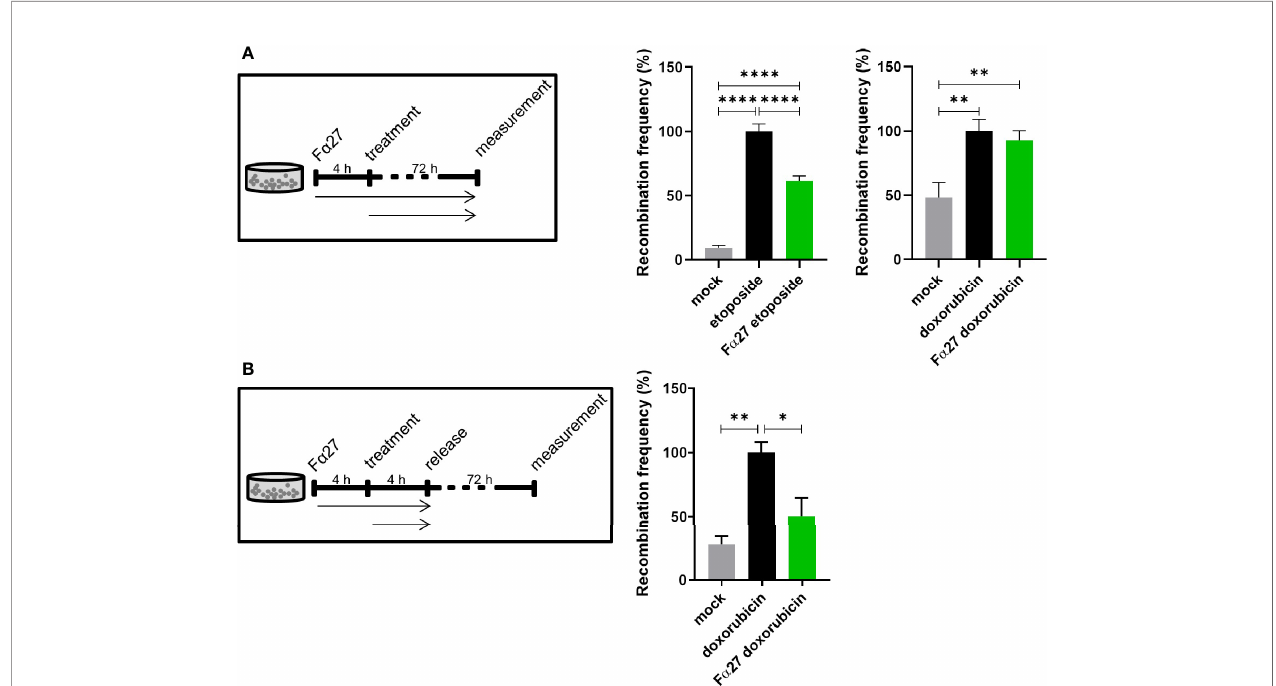
FIGURE 2 | F a 27 differentially affects MLL bcr rearrangements in WTK1MLL cells after etoposide and doxorubicin treatment. (A) Continuous exposure of WTK1MLL cells to peptide and chemotherapeutic drugs. WTK1MLL cells were treated for 4 h with 1 mg/ml F a 27 followed by 72 h with F a 27 plus 10 µM etoposide or 10 µg/ml F a 27 followed by F a 27 plus 0.5 µM doxorubicin, respectively (n=12 obtained in four independent experiments). EGFP-positive cells were counted after 72 h by FACS. After etoposide but not doxorubicin treatment F a 27 reduced the recombination frequency signi fi cantly. (B) Release of WTK1MLL cells after peptide- and doxorubicin treatment. WTK1MLL cells were treated for 4 h with 10 µg/ml F a 27 followed by 4 h with F a 27 plus 0.5 µM doxorubicin treatment (n=6 from two individual experiments). Thereafter, the cells were released by washing with PBS and seeding in fresh medium. FACS analysis showed a signi fi cant reduction of the doxorubicin-induced recombination frequency by F a 27 pre-treatment. Mean recombination frequencies induced by etoposide (8.5x10 -5 ) and by doxorubicin (1.8x10 -5 ) were set to 100% for each experimental day. All values are represented as mean +SEM (*p < 0.05, **p < 0.01, ****p <